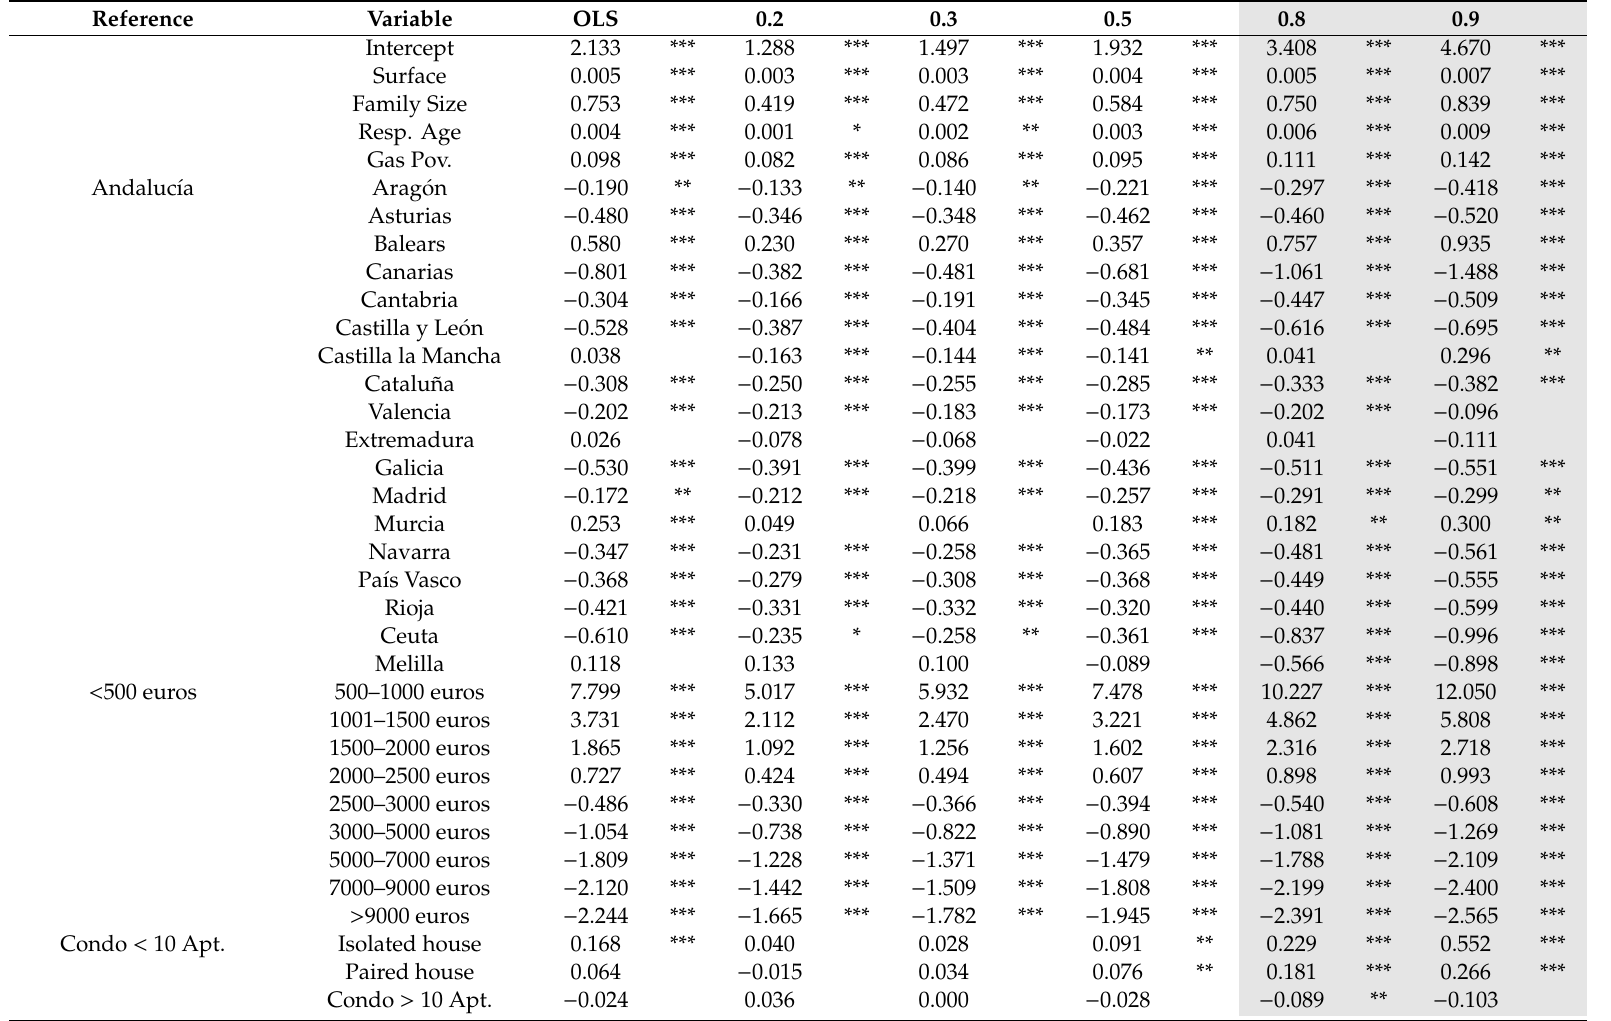
Table 4. Regression results for Indicator 1 of electricity poverty. (Endogenous variable: Electricity Expenditure / Total Expenditures) × 100.